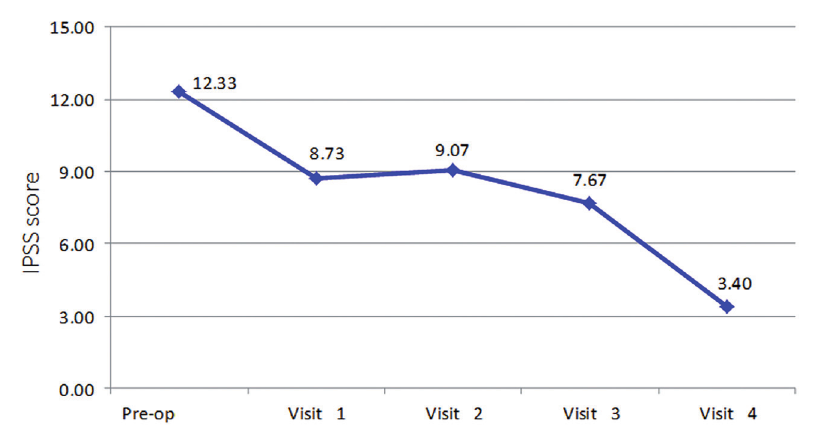
Figure 5 - IPSS score per medical